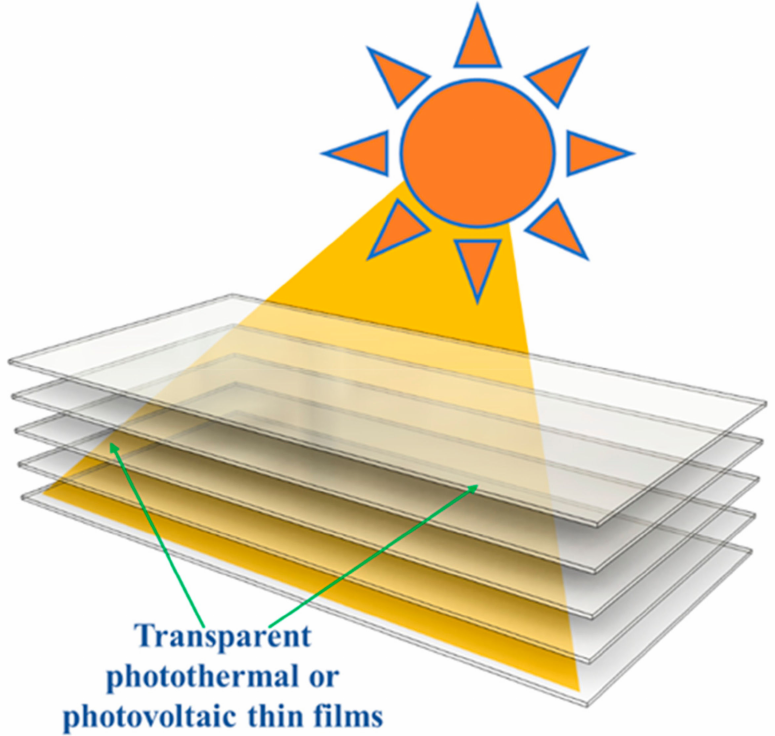
Figure 1. Schematic diagram showing the concept of 3D multilayer solar light harvesting. However, the optical absorption requirements for photovoltaics (PV) are distinctively different. It is well known that the power conversion efficiency (PCE) of PV cannot surpass the Shockley–Queisser limit (SQ limit) [34]. The SQ model is established based on intrinsic limitations, such as blackbody radiation, recombination, and spectral losses. The spectral losses are limited by the bandgap energy (Eg). Photons with energies lower than Eg do not contribute to the short-circuit current (Isc) of the solar panel [35]. For instance, in the case of silicon, with an Eg of 1.1 eV, about 19% of photons have energies lower than 1.1 eV, which constitutes around 33% of the incident sunlight. The spectral response is the ratio of current generated by the solar panel to the power incident on it. The high-energy photons close to the ultraviolet (UV) spectrum contribute to thermalization for silicon semiconductors